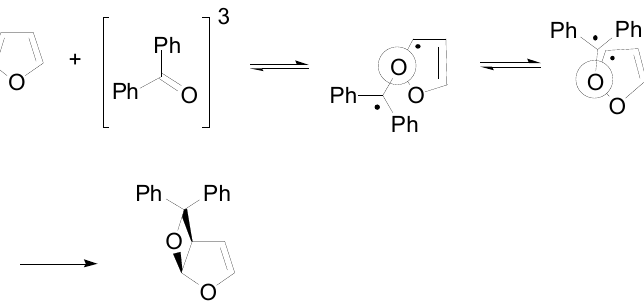
O OPh Ph O OO O